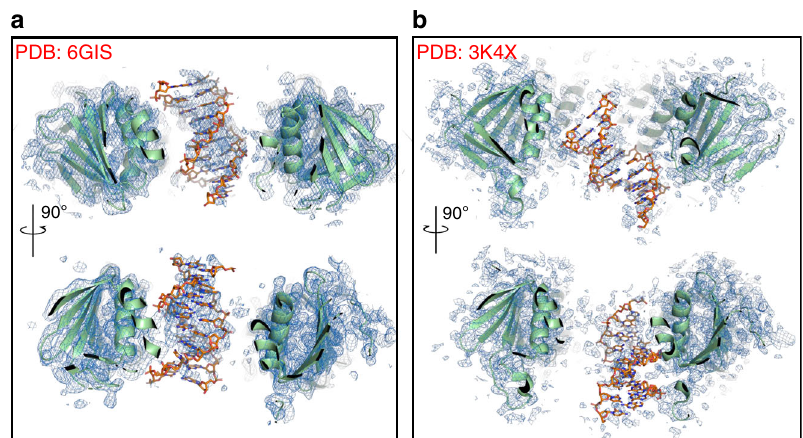
Fig. 1 PCNA – DNA complexes OMIT maps. a Two views of the composite OMIT map of the human PCNA – DNA complex (PDB-ID 6GIS) 1 contoured at 0.9 σ showing the PCNA central channel. PCNA is shown as a ribbon, DNA as sticks. b Two views of the composite OMIT map of the yeast PCNA – DNA complex (PDB-ID 3K4X) 4 contoured at 0.9 σ